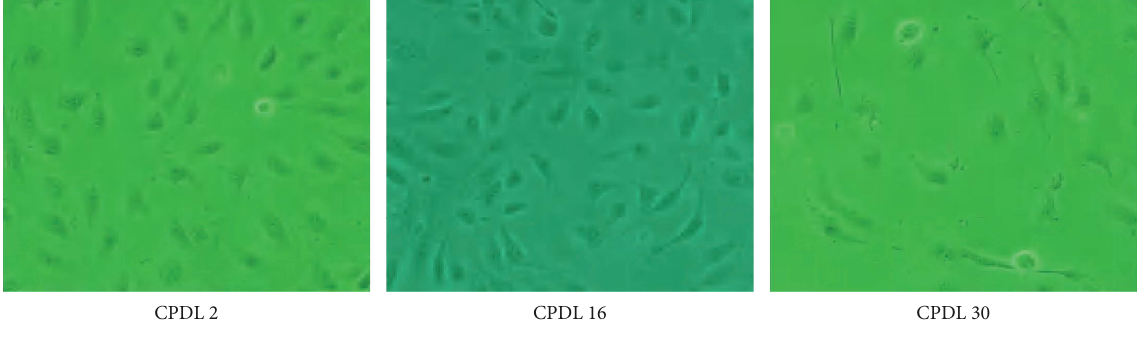
Figure 2: Morphology of HUVECs at diferent CPDLs under optical microscopes (200 × ).